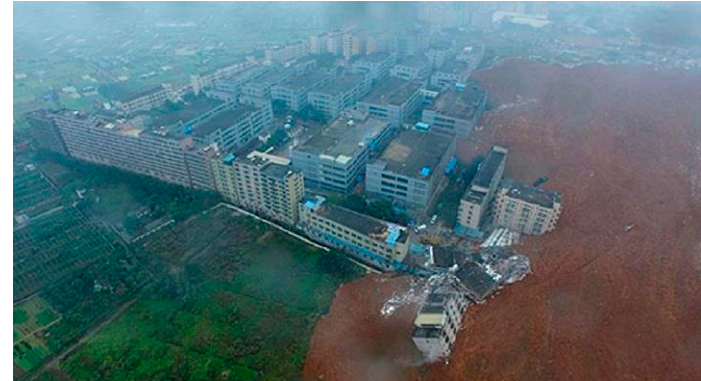
Figure 5. C&D waste landfill landslide in Shenzhen, China [105].